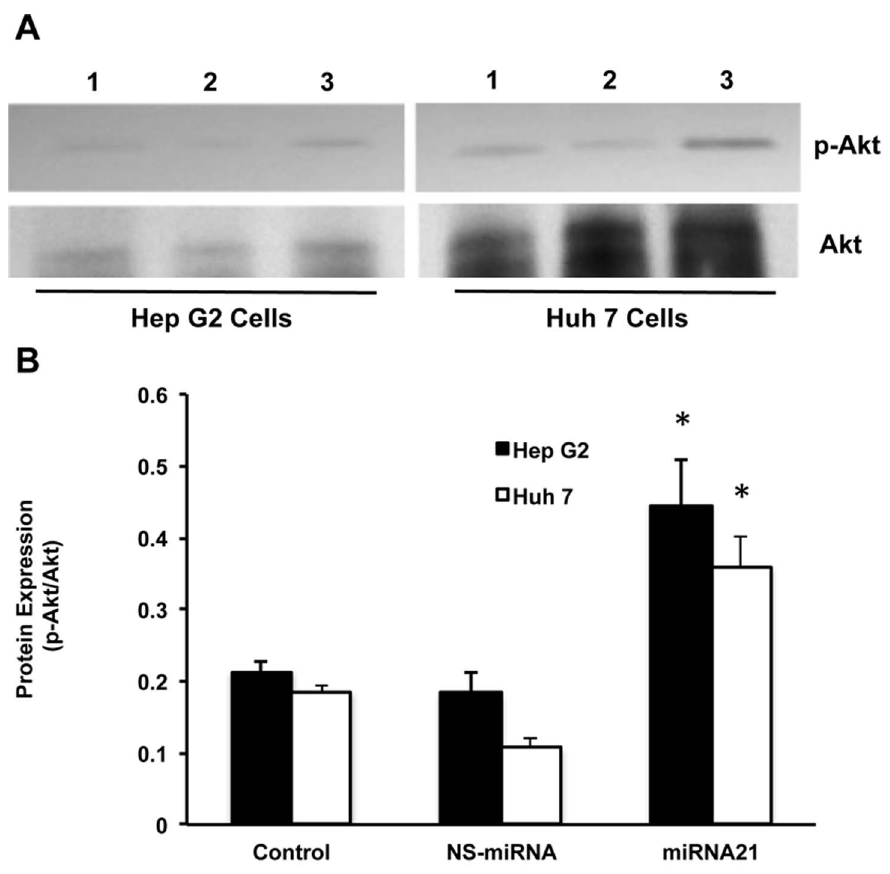
Figure 6. Effect of miRNA-21 on phospho-akt levels. A, shows the Western blot results of phsopho-akt and akt proteins in the miRNA-21- transfected cells. This is a representative picture from three experiments. Lane 1, Control; lane 2, NS-miRNA transfected cells; and lane 3, miRNA-21 transfected cells. B, Western blots were quantified and the data are presented in the graph (n=3; *p , 0.05).